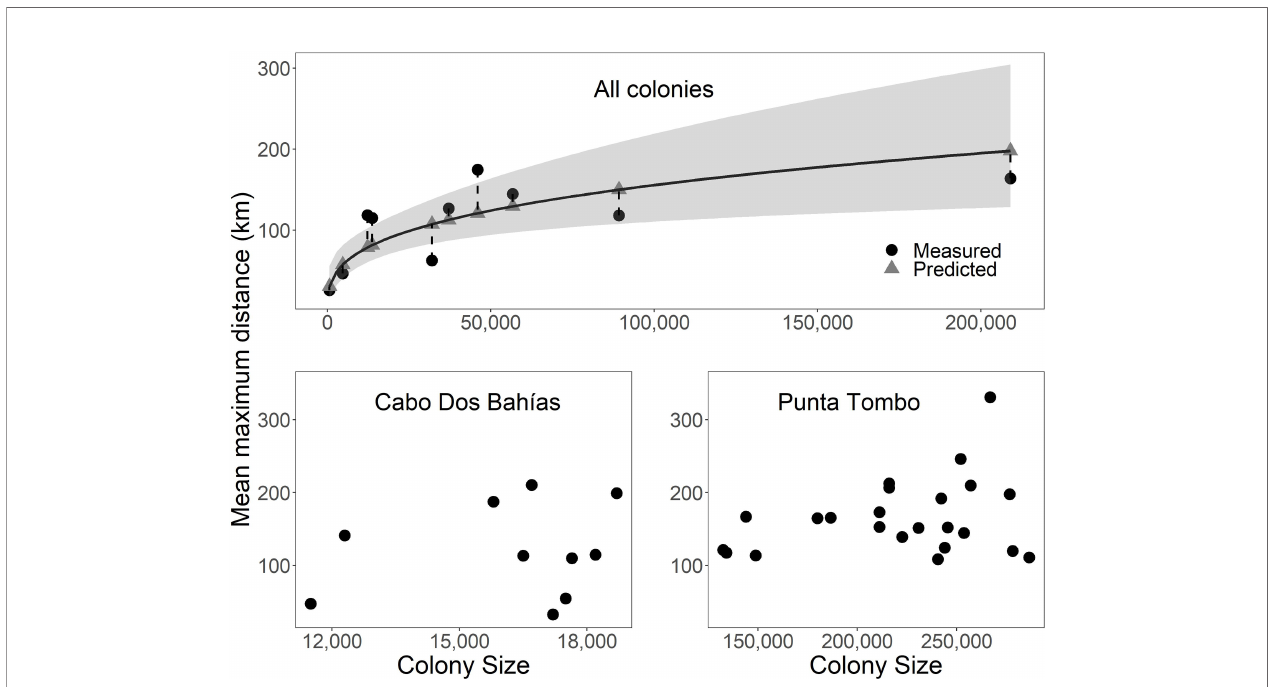
FIGURE 2 | The relationship between colony size (pairs or active nests) and foraging distance in Magellanic penguins at 10 breeding colonies in Argentina was signi fi cant (curved solid line, p = 0.002, R 2 = 0.70), but not predictive for several colonies (vertical dashed lines connect predicted and measured distances; gray ribbon represents 95% con fi dence intervals) (Top). Colony size was not signi fi cantly related to foraging distance within colony among years for Cabo Dos Bah ı ́ as ( p = 0.60, R 2 < 0.01; Bottom left) or Punta Tombo ( p = 0.39, R 2 < 0.01; Bottom right). Mean maximum distance is the mean of the maximum distances for each